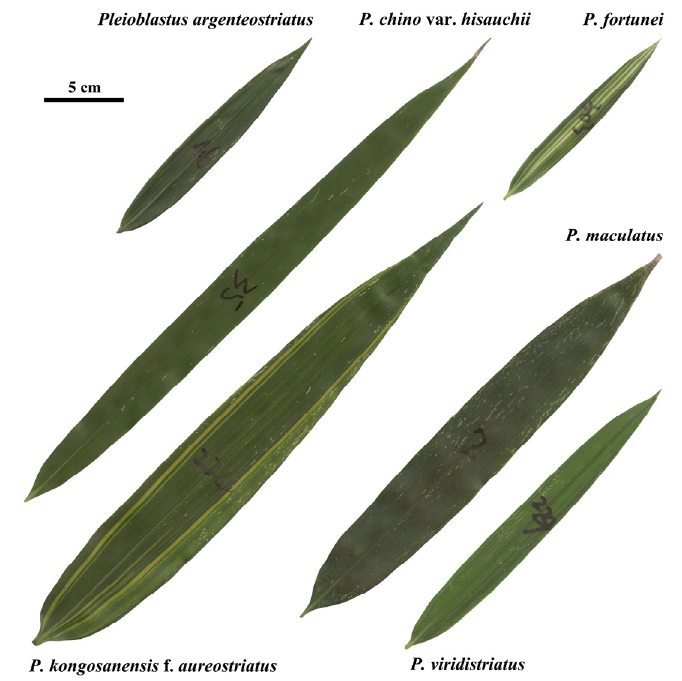
Figure 1. Outlines of leaf samples of six Pleioblastus species collected from the Nanjing Forestry University